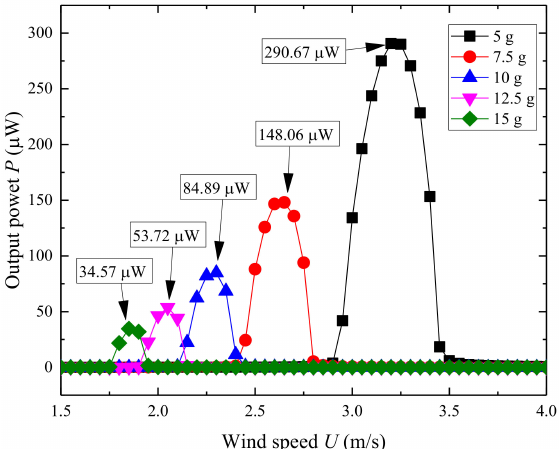
Figure 6. Output power of UPEH versus wind speed with different mass of